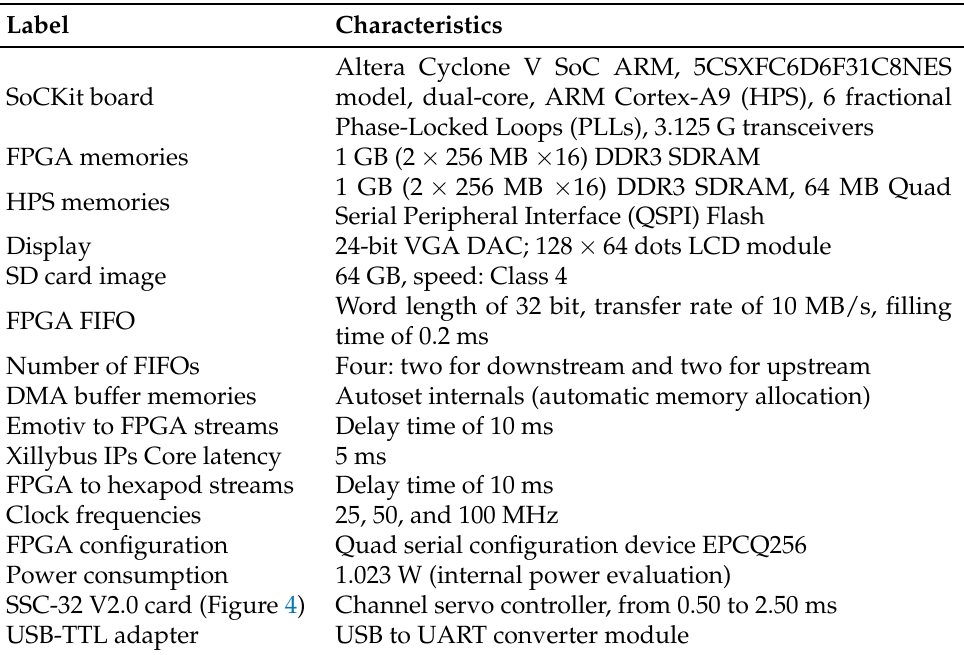
Table 1. SoCKit resources and materials deployed for the project implementation. HPS, Hard Processor